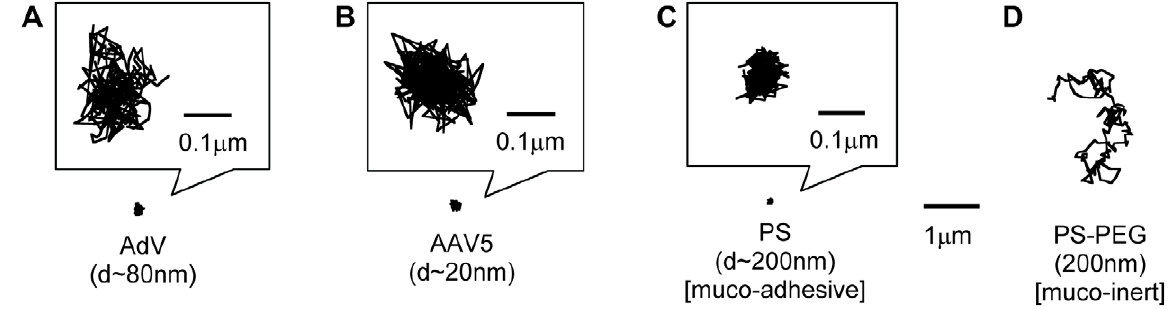
Figure 1. Sample 20 s trajectories. Representative trajectories of (A) Adenovirus (Adv), (B) AAV5, (C) muco-adhesive PS control nanoparticles and (D) muco-inert control PS-PEG nanoparticles. All trajectories have MSD values within one standard deviation of the ensemble average.